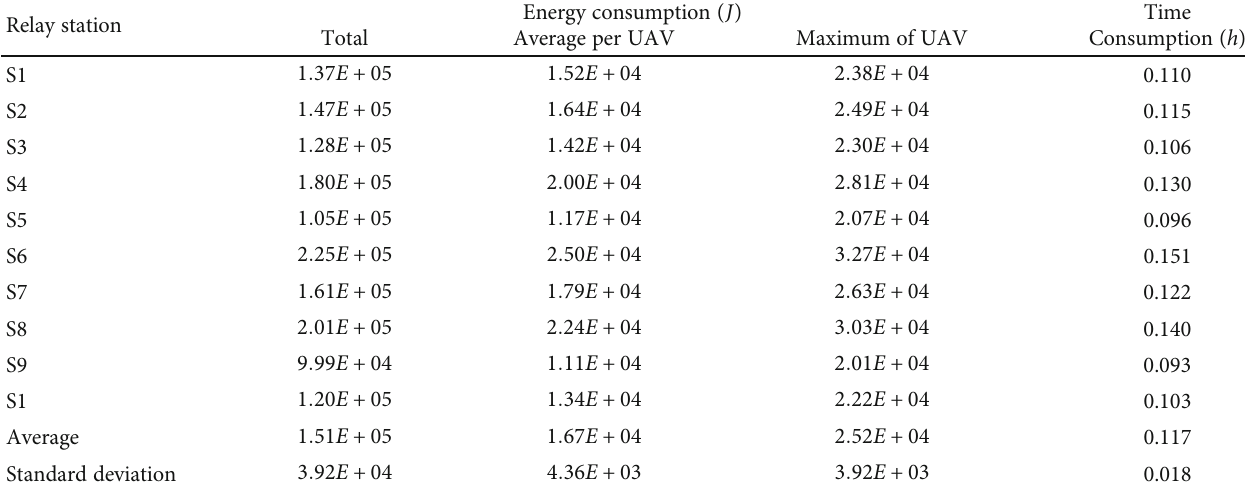
Table 3: The experimental results of 10 relay stations in the simple cooperative task.